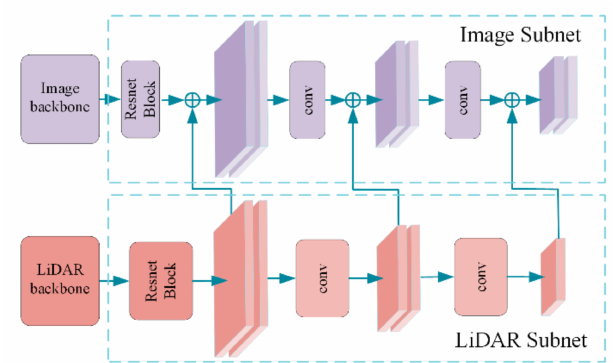
Figure 6. Visualization of the multi-sensor multi-level composite module. The feature maps in the LiDAR subnet are added to the feature maps in the Image subnet in a recursive manner. This idea was originally published by CBNet [26]. We extend the composite methodology into the multi-sensor fusion field with a recursive multi-sensor multi-level composite